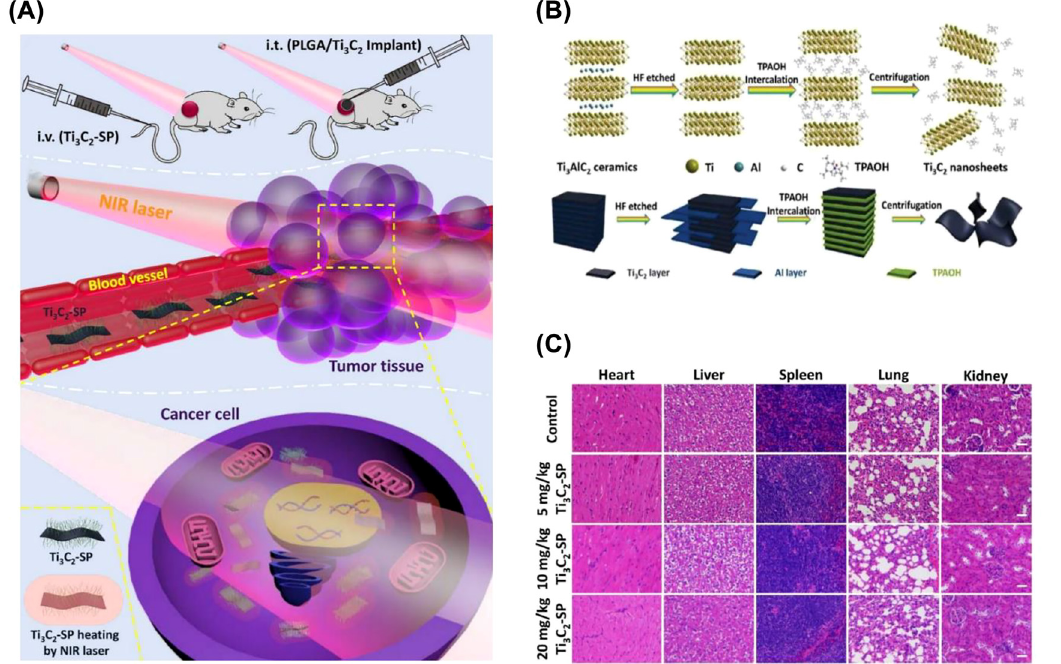
C -SP and intratumoral injection of 3 2 C nanosheet. (C) H&E staining of 3 2 C -SP doses (5, 10, and 3 2